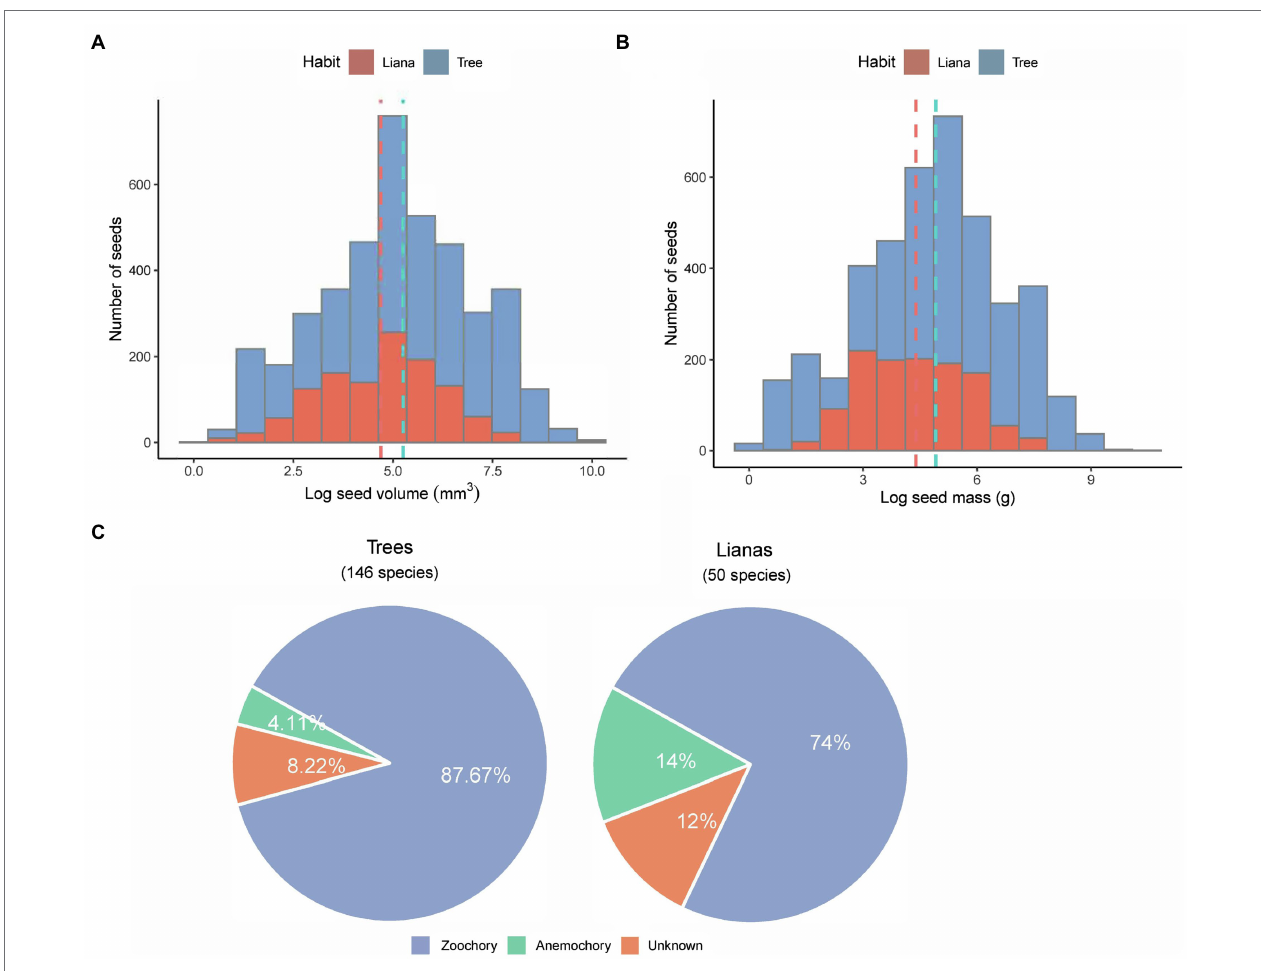
FIGURE 2 | Overview of the seed size between trees and lianas. Histogram distributions of (A) seed volume and (B) seed mass. All bin widths are logarithmically scaled to facilitate comparison. (C) pie charts showing number of species and their dispersal modes in the